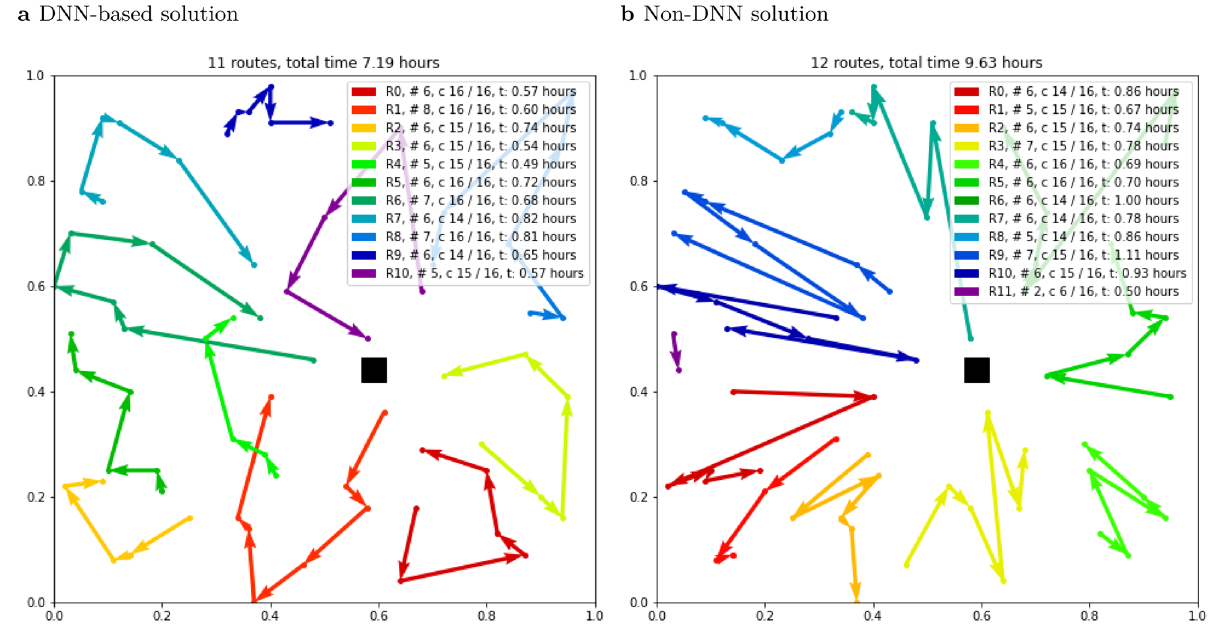
Figure 1. An example of DNN-based and non-DNN solutions. Information in each legend box is in the format 42 “R0, #6, c 14/16, t: 0.86 h”. R0 is the first route, R1 is the second, etc. “#6” means that the emergency vehicle visits 6 houses in that route. “c 14/16” indicates that the emergency vehicle whose passenger capacity is 16 people picks up 14 people in route R0. Finally, “t: 0.86 h” means that the emergency vehicle spends 0.86 h in route R0. To make the routing pattern easy to read 42 , we hide the first and the last line going from and back to the black square, which represents the transition point for transit to the depot. The total time and the number of routes required to pick up every resident on the special needs registry are shown at the top of Fig. 1. This example is for vehicle capacity = 16 and transit time = 0.